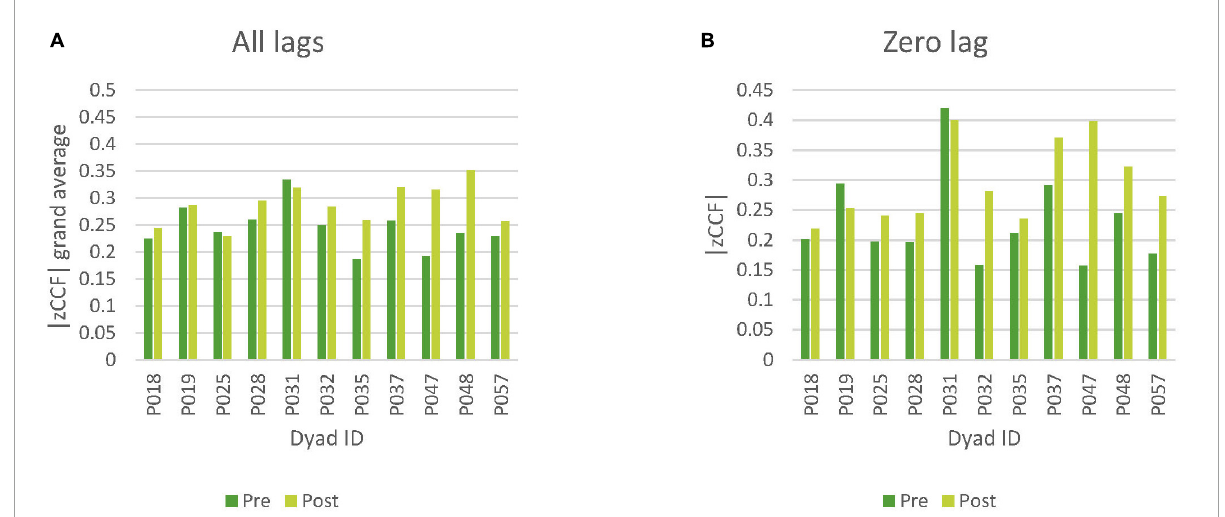
FIGURE5 Comparison of pretalk and posttalk nonverbal synchrony. (A) Comparison based on all lags values (grand average). (B) Comparison based on lag zero values (only lag zero cross-correlations). |zCCF| Fisher’s Z absolute mean cross-correlation.